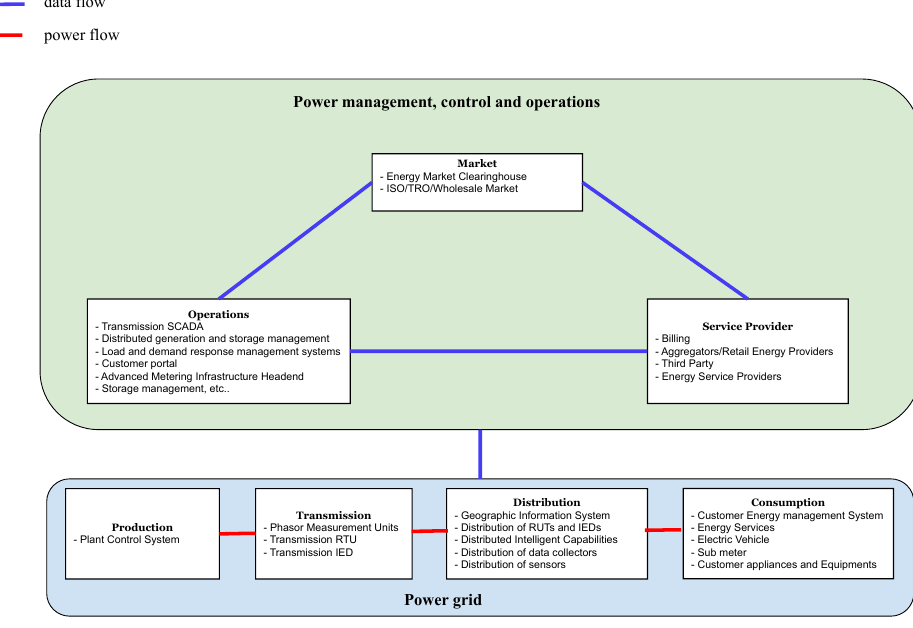
Figure 1. An overview of stakeholders in the different smart grid